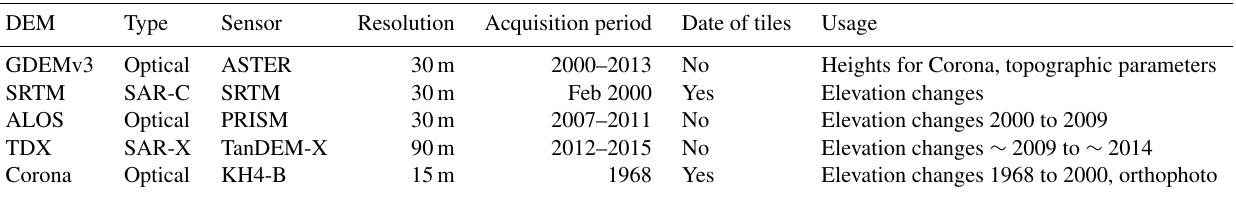
Table 2. Selected characteristics of available DEMs and their usage in this study. DEM Type Sensor Resolution Acquisition period Date of tiles Usage GDEMv3